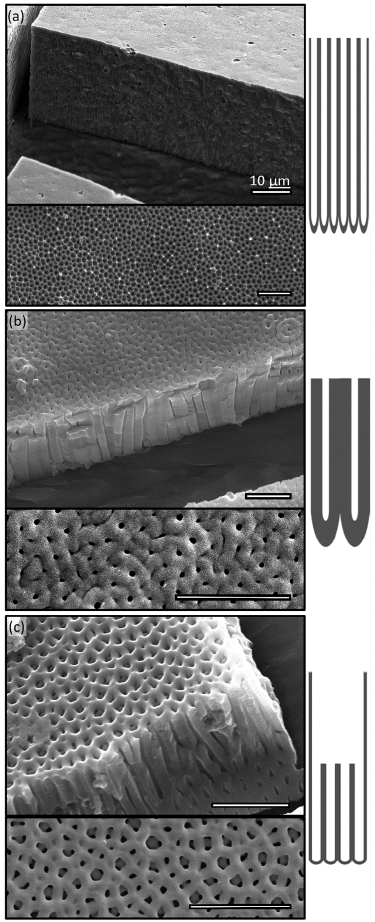
Figure 2. Topological features of AAO samples using different fabrication parameters: each consists of SEM micrographs (top) tilted at 15°, (bottom) from top view, and (side) illustration of AAO cross-section. Sample topological features include: ( a ) thin wall nano-pores with large aspect ratio (e.g., pore depth: diameter >100:1), which is anodized at 1 °C and 60 V for 4 h. ( b ) thick wall pores with a small